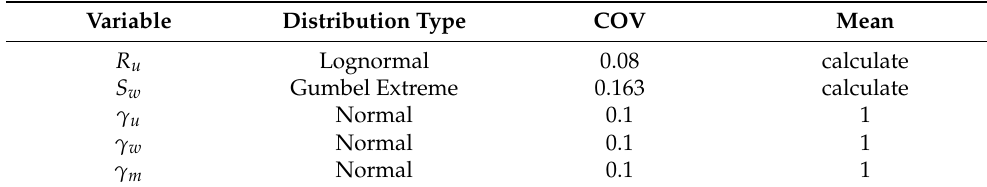
Table 4. Failure function stochastic